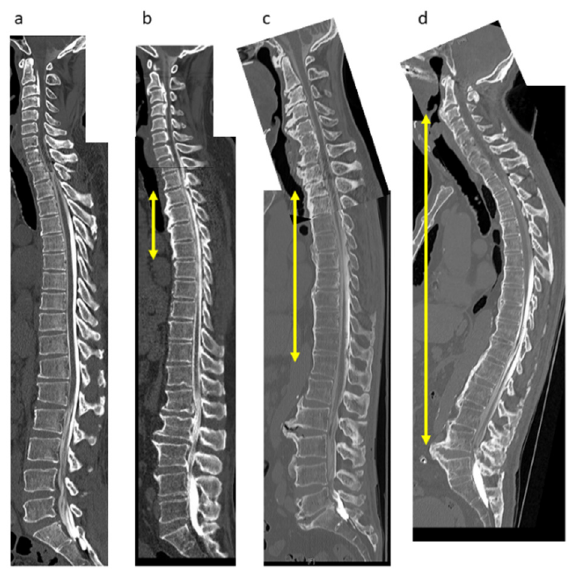
Figure 1. DISH grading system. ( a ) No DISH; ( b ) Grade 1 (bony bridge at T3–T6); ( c ) Grade 2 (T2–T12); ( d ) Grade 3 (C2–L5). DISH, diffuse idiopathic skeletal hyperostosis.